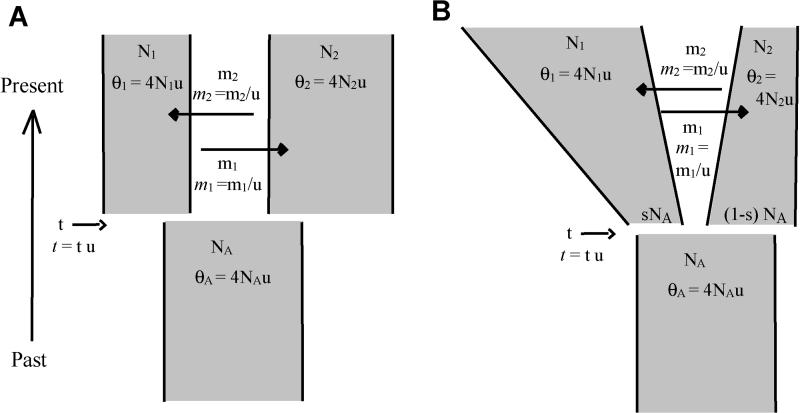
Isolation with Migration Models(A) The basic IM model. The demographic terms are effective population sizes (N1, N2, and NA), gene flow rates (m1 and m2), and population splitting time (t). Also shown are parameters scaled by the neutral mutation rate (u), as they are actually used in the model fitting. Terms for basic demographic parameters, including N, m, t, and u, are not italicized. Note that the migration parameters are identified by the source of migrants as time goes backward in the coalescent. In other words, the migration rate from population 1 to population 2 (i.e., m1) actually corresponds to the movement of genes from population 2 to population 1 as time moves forward.(B) The IM model with changing population size. An additional parameter, s, is the fraction of NA that forms N1 (i.e., the fraction 1 − s gives rise to N2)